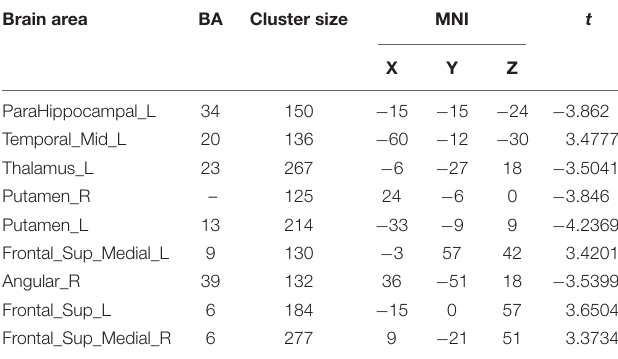
TABLE 4 | Brain area with abnormal ReHo value in MDD